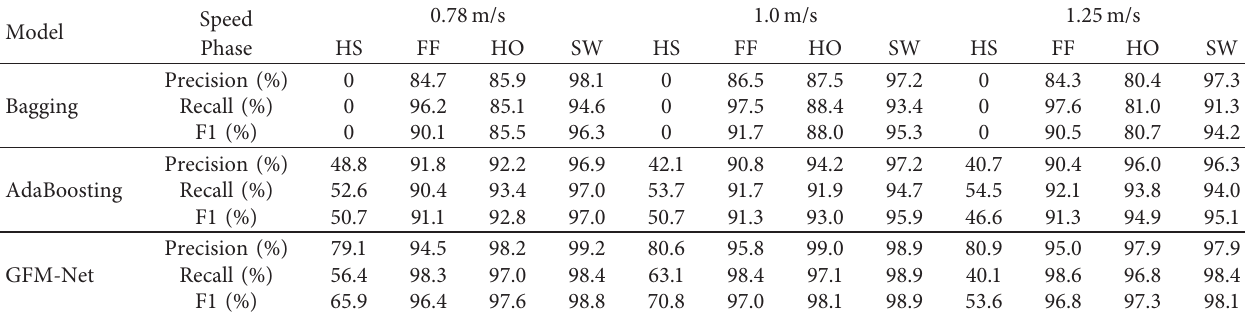
Table 1: Summary of classification performance of different models at unsynchronized speed.